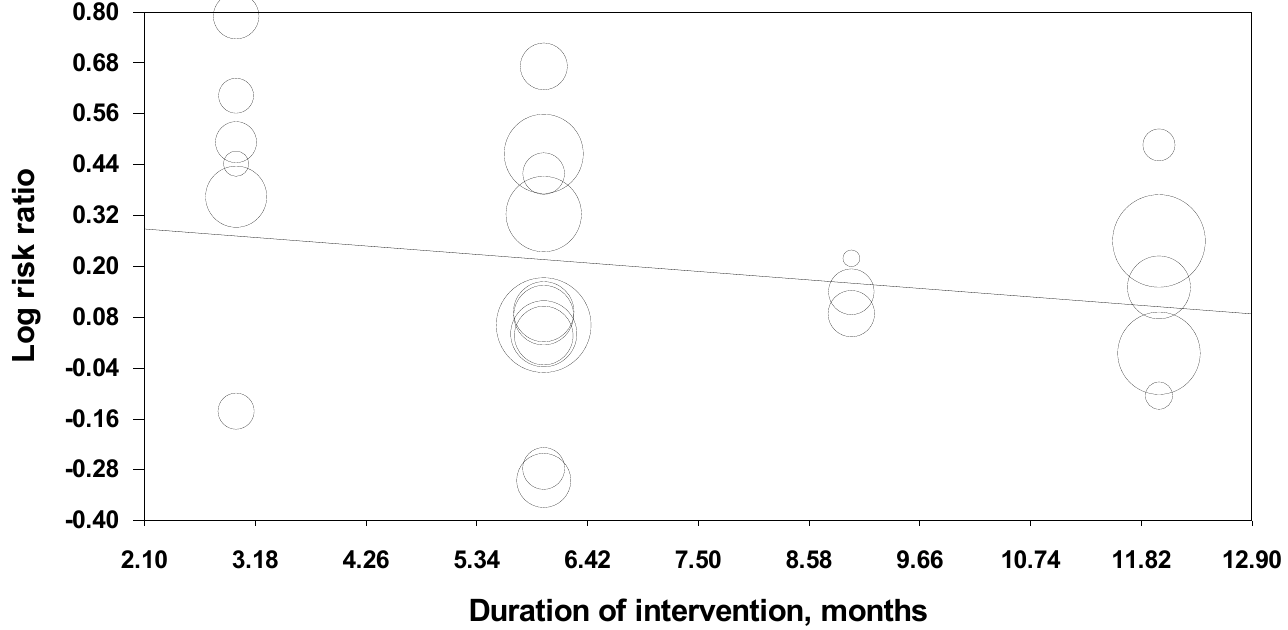
); RBPM, remote blood pressure monitoring. (cid:35)